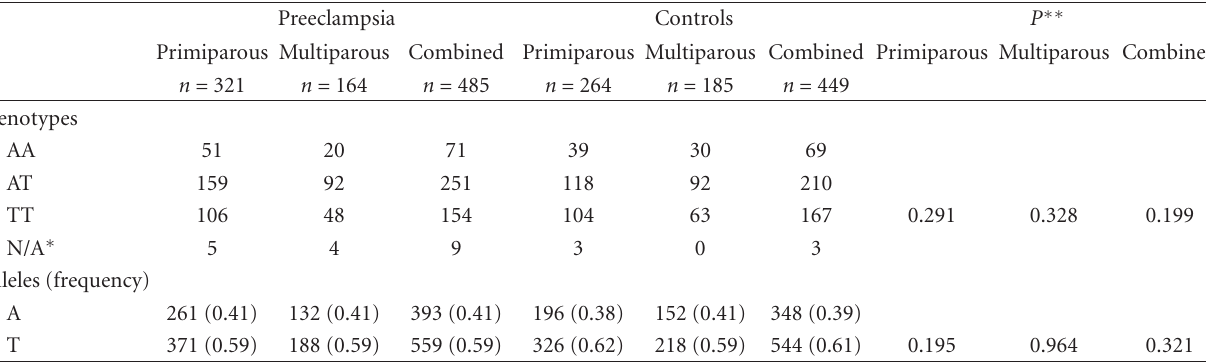
Table 2: FTO SNP rs9939609 genotypes and allele counts among the Finnish preeclampsia patients and control subjects from data sets 1, 2, and 3.